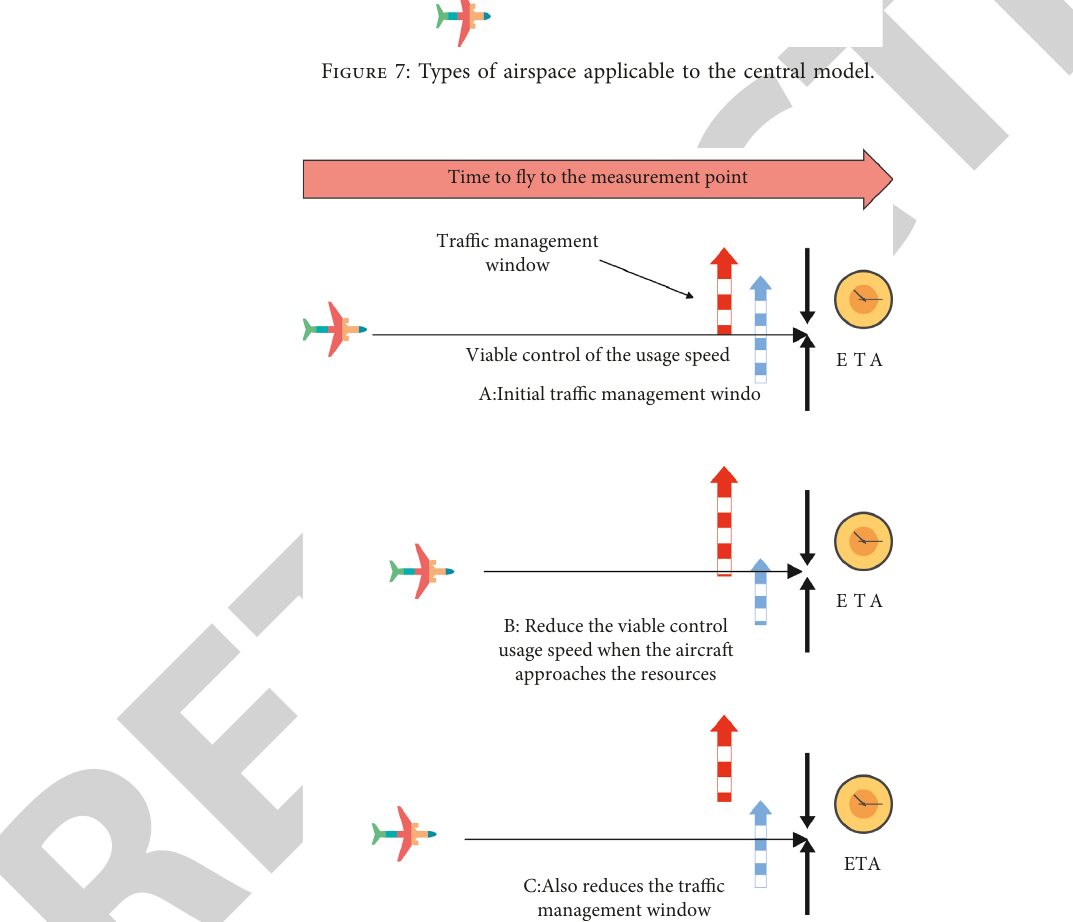
Figure 8: Adjustment range of air traffic flow management of civil aviation based on the spatial data